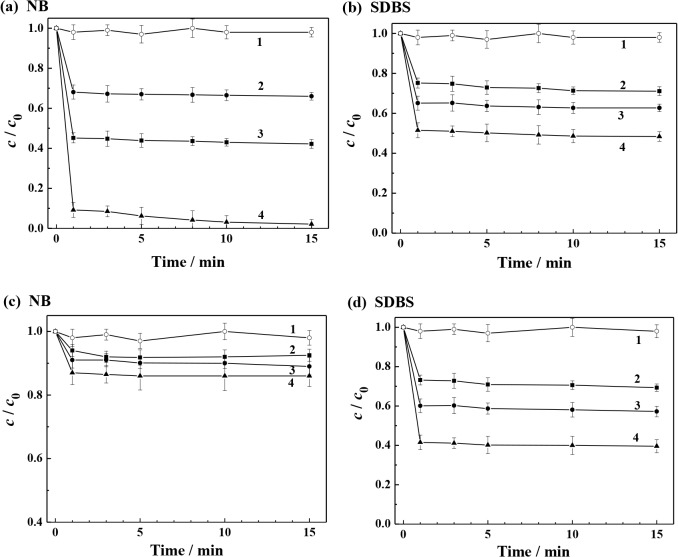
Degradation profiles of NB and SDBS in the washing effluent with the addition of H2O2 or persulfate.Degradation conditions in (a) and (b) were (1) 20.0 mmol L-1 S2O8
2−, (2) 20.0 mmol L-1 Fe2+ + 20.0 mmol L-1 S2O8
2−, (3) 40.0 mmol L-1 Fe2+ + 40.0 mmol L-1 S2O8
2−, and (4) 80.0 mmol L-1 Fe2+ + 80.0 mmol L-1 S2O8
2−. Degradation conditions in (c) and (d) were (1) 20.0 mmol L-1 H2O2, (2) 20.0 mmol L-1 Fe2+ + 20.0 mmol L-1 H2O2, (3) 40.0 mmol L-1 Fe2+ + 40.0 mmol L-1 H2O2 and (4) 80.0 mmol L-1 Fe2+ + 80.0 mmol L-1 H2O2. The effluent composition: NB 0.015 mmol L−1, SDBS 9.4 mmol L−1, and pH 3.0.